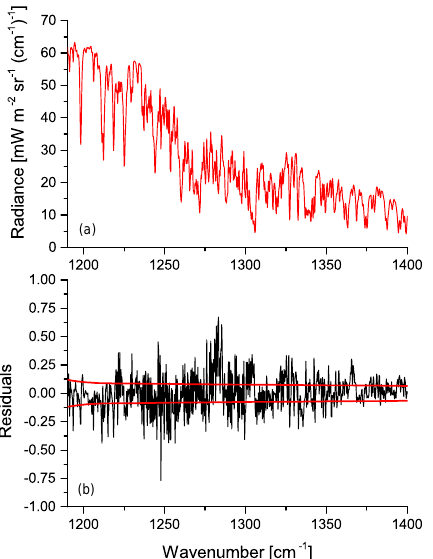
Figure 1. Example of an infrared spectrum measured by IASI (a) and residuals between the satellite observation and radiative trans- fer simulation (b) at Manus Island (15 Octover 2012 11:46:26UT, satellite zenith angle 10.2 ◦ , integrated water vapour 48.0mm). The red lines in the bottom panel indicate the typical IASI noise mea- surement level as given by the square root values of the diagonal el- ements of the IASI noise covariance matrix (Pequignot et al.,